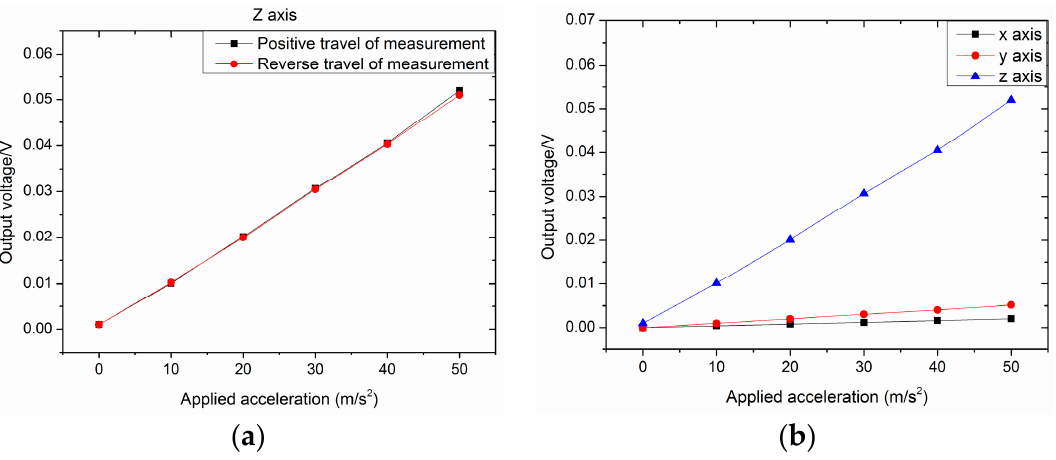
Figure 16. Testing results. ( a ) Positive and reverse travel of measurement; ( b ) Output voltage of the Z -, X -, and Y -axes.